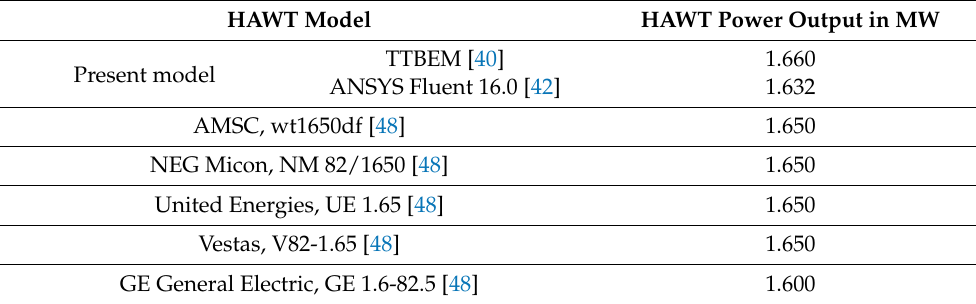
Table 1. Power output of present HAWT and commercial HAWTs of same rotor dimensions and at air velocity equal to 10 m · s − 1 [48].